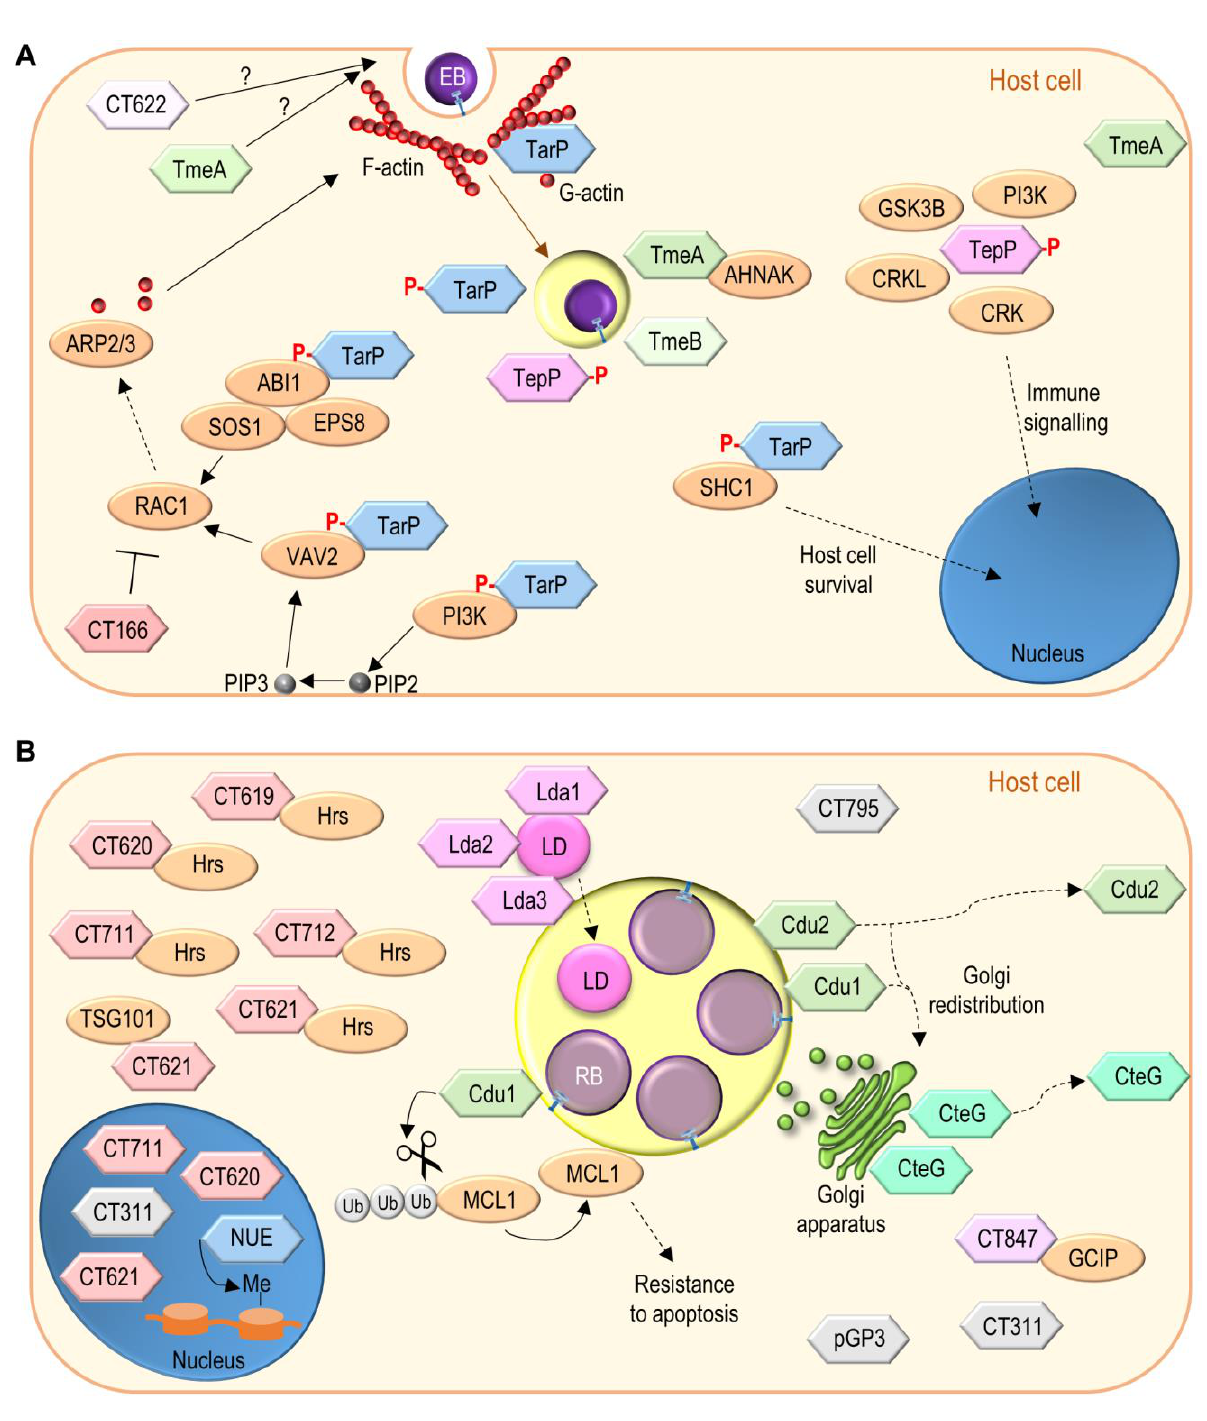
FIGURE 4: Function of non-Inc C. trachomatis effectors. (A) C. trachomatis effectors (TarP, TmeA, TmeB, CT166, CT622) packed in EBs and delivered into host cells during invasion; besides TarP, TmeA and CT622 also promote C. trachomatis invasion but their mode of action is unknown. (B) C. trachomatis non-Inc proteins that have been detected in the host cell cytoplasm, nucleus, or inclusion membrane (Cdu1, Cdu2, CteG, Lda1, Lda2, Lda3, NUE, pGP3, CT311, CT620, CT621, CT711, and CT795; GlgX, CopN, Cap1, GlgA, HtrA, and CPAF are not repre- sented) or for which there is functional evidence for an effector role (CT619, CT712, CT847). It is unclear whether these proteins are deliv- ered into host cells by EBs or by RBs (as represented), or by both chlamydial forms. Among the chlamydial proteins represented and not binding a host cell protein, pGP3 has been shown to interact with the antimicrobial peptide cathelicidin LL-37 but this likely occurs extra- cellularly [276]. See list of abbreviations, main text, and Table 2 for